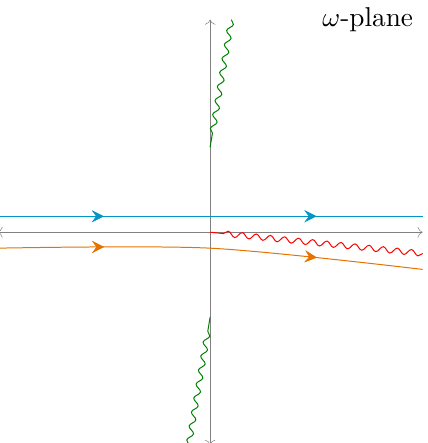
Figure 2 . A generic amplitude T ( s, t ) when translated to the ω plane will NOT satisfy T ( ω, z ) ∗ = T ( ω ∗ , z ) . Note that the t -channel branch cuts of the amplitude unfold (green) along the imaginary ω